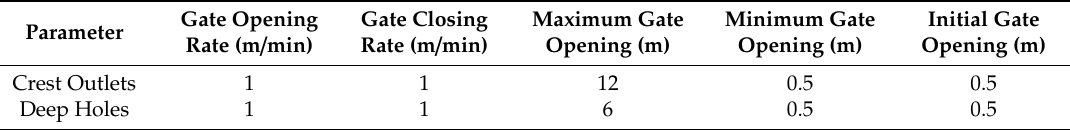
Table 2. Design of orifice switch parameters of the Yebatan arch dam when the comprehensive flood control of blocking and draining are integrated.